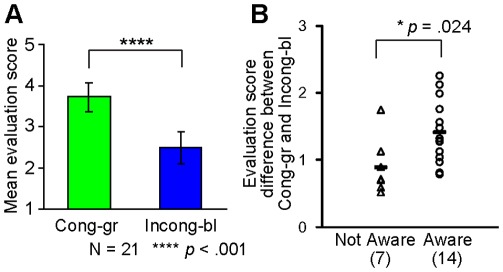
Action evaluation of one’s own motor behavior.(A) Mean evaluation scores in the congruent-green and incongruent-blue conditions of the practice phase. Error bars indicate the SDs of the evaluation scores between participants. (B) Difference of evaluation scores between the congruent-green and incongruent-blue conditions of the practice phase. Triangles denote the data for each participant of the “not aware” group, those who did not report an association between their own performance and the color cue. Circles denote that of the “aware” group, those who reported an association between their own performance and the color cue.